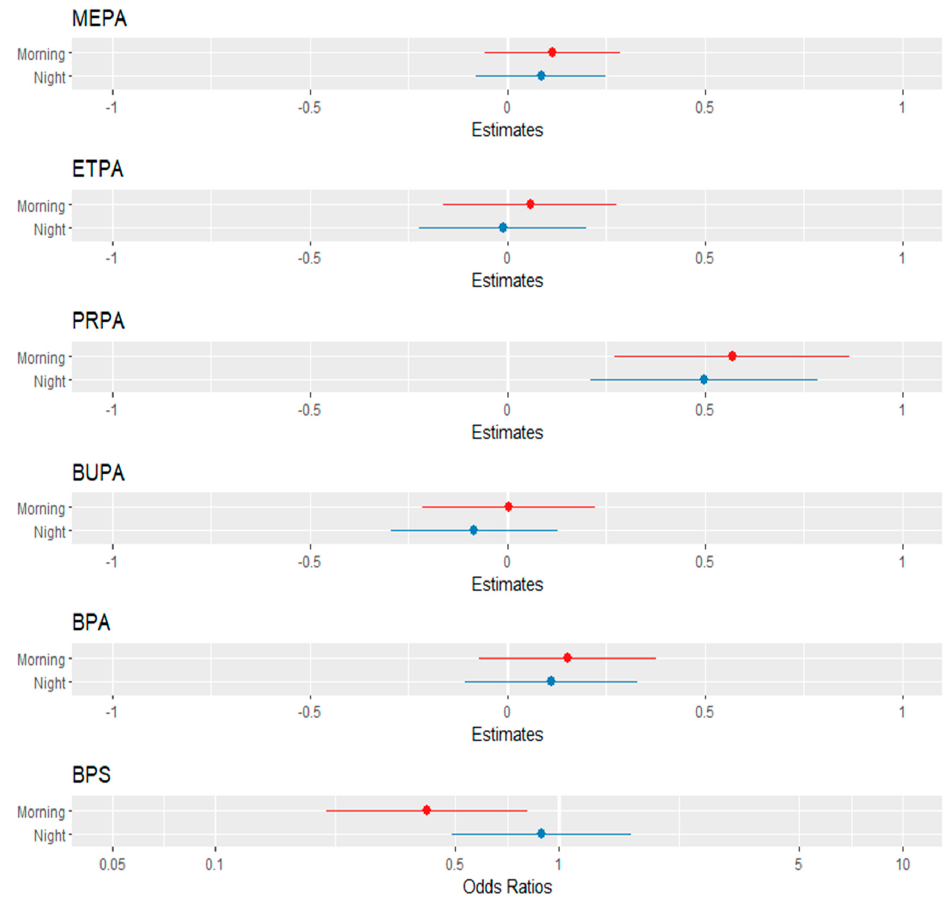
Figure 3. Forest plot visualization of the linear mixed-effect models of SG-adjusted parabens and bisphenols as a function of time of urine sampling in the day adjusted for dietary habits and personal-care-product use (reference: mid-day = zero point on x -axis). Table 3. Mixed-effect models for the association between the SG-adjusted and logarithm transformed biomarkers of exposure to EDCs and the biomarker of effect